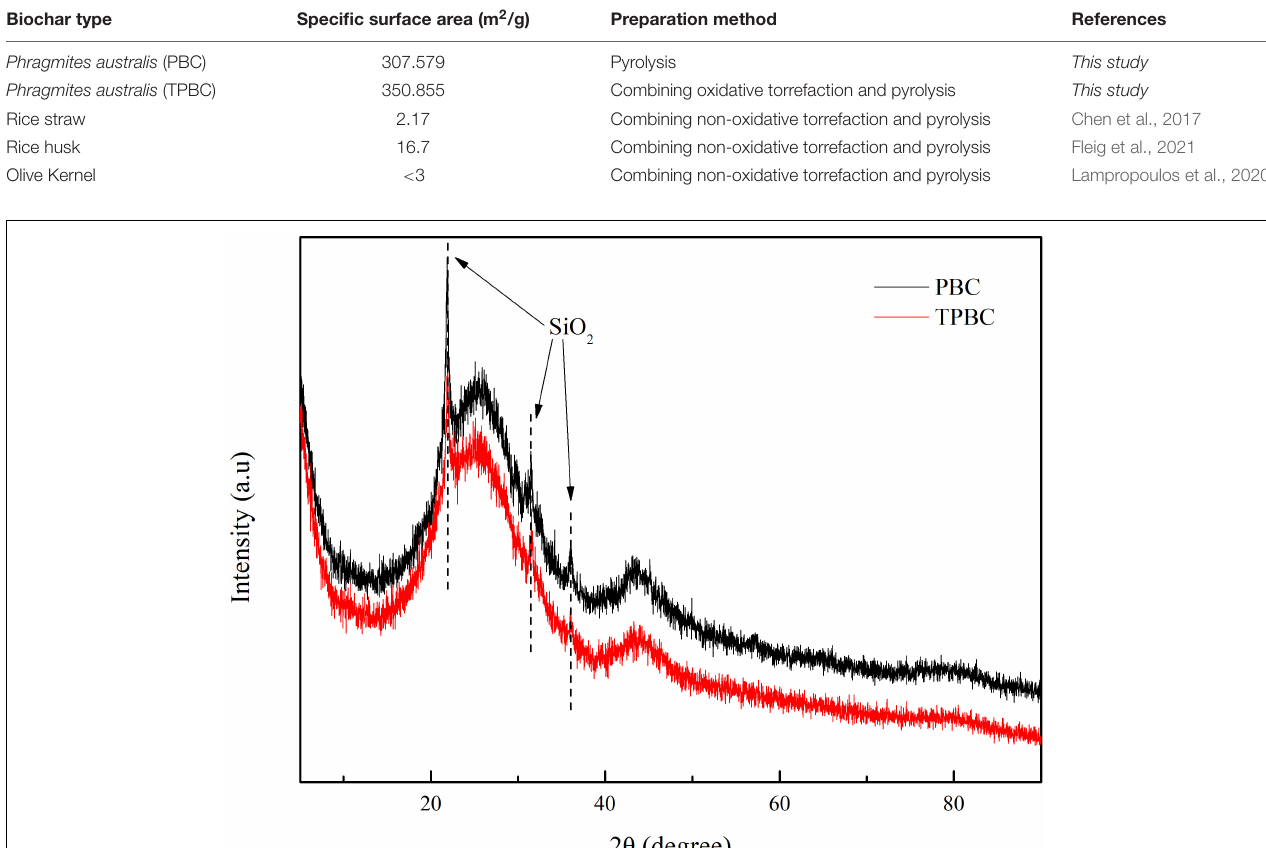
TABLE 1 | The specific surface areas of the PBC and TPBC, and comparison of the results with similar studies.